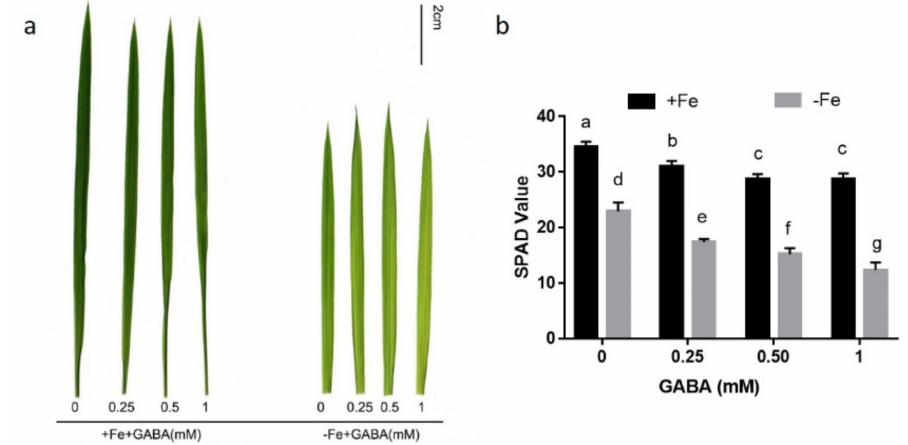
Figure 1. Morphological responses in the fully expanded youngest leaf treated by γ -Aminobutyric acid (GABA) under conditions of Fe-sufficiency (FS) or -deficiency (FD). Two-week-old seedlings were treated with different concentrations of GABA with or without FeSO 4 (20 µ M) for two weeks. ( a ) Photos of leaves in rice seedlings grown in different conditions. ( b ) The soil–plant analysis development (SPAD) value of leaves in rice plants. Data are the means ± SD ( n = 10). Different letters denote a remarkable difference ( p ≤ 0.05).